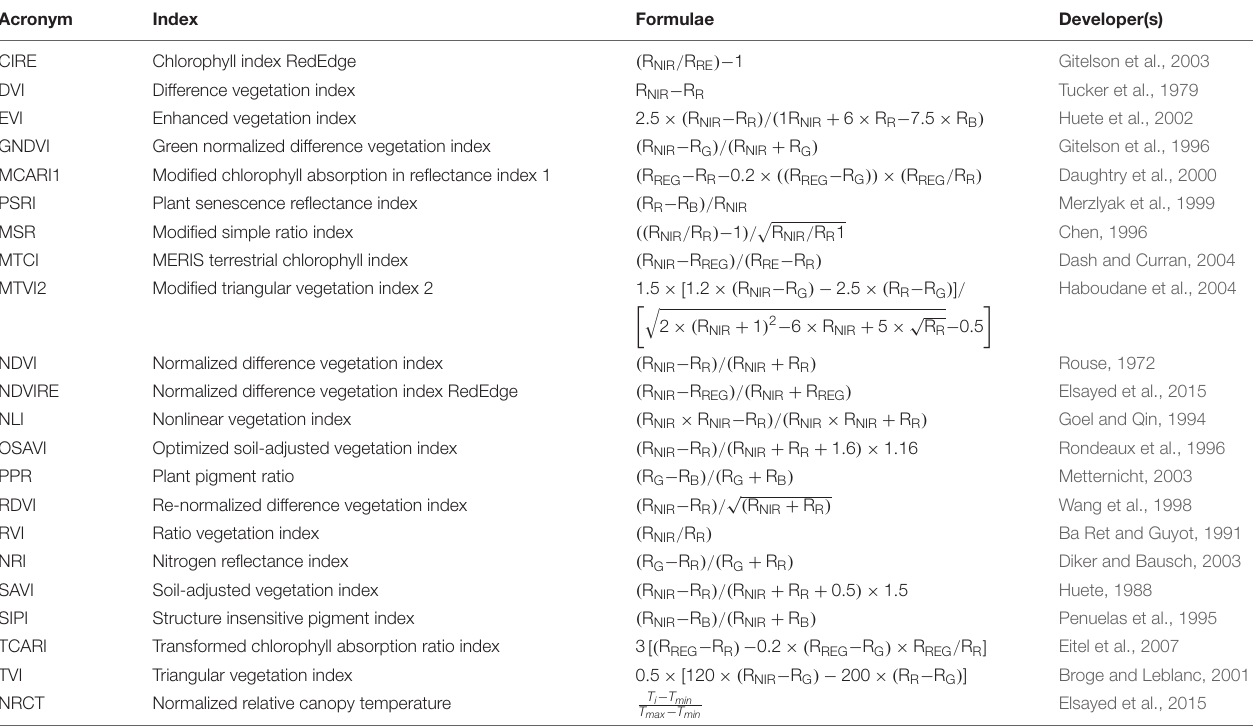
TABLE 2 | Formulae of multispectral vegetation indices and normalized relative canopy